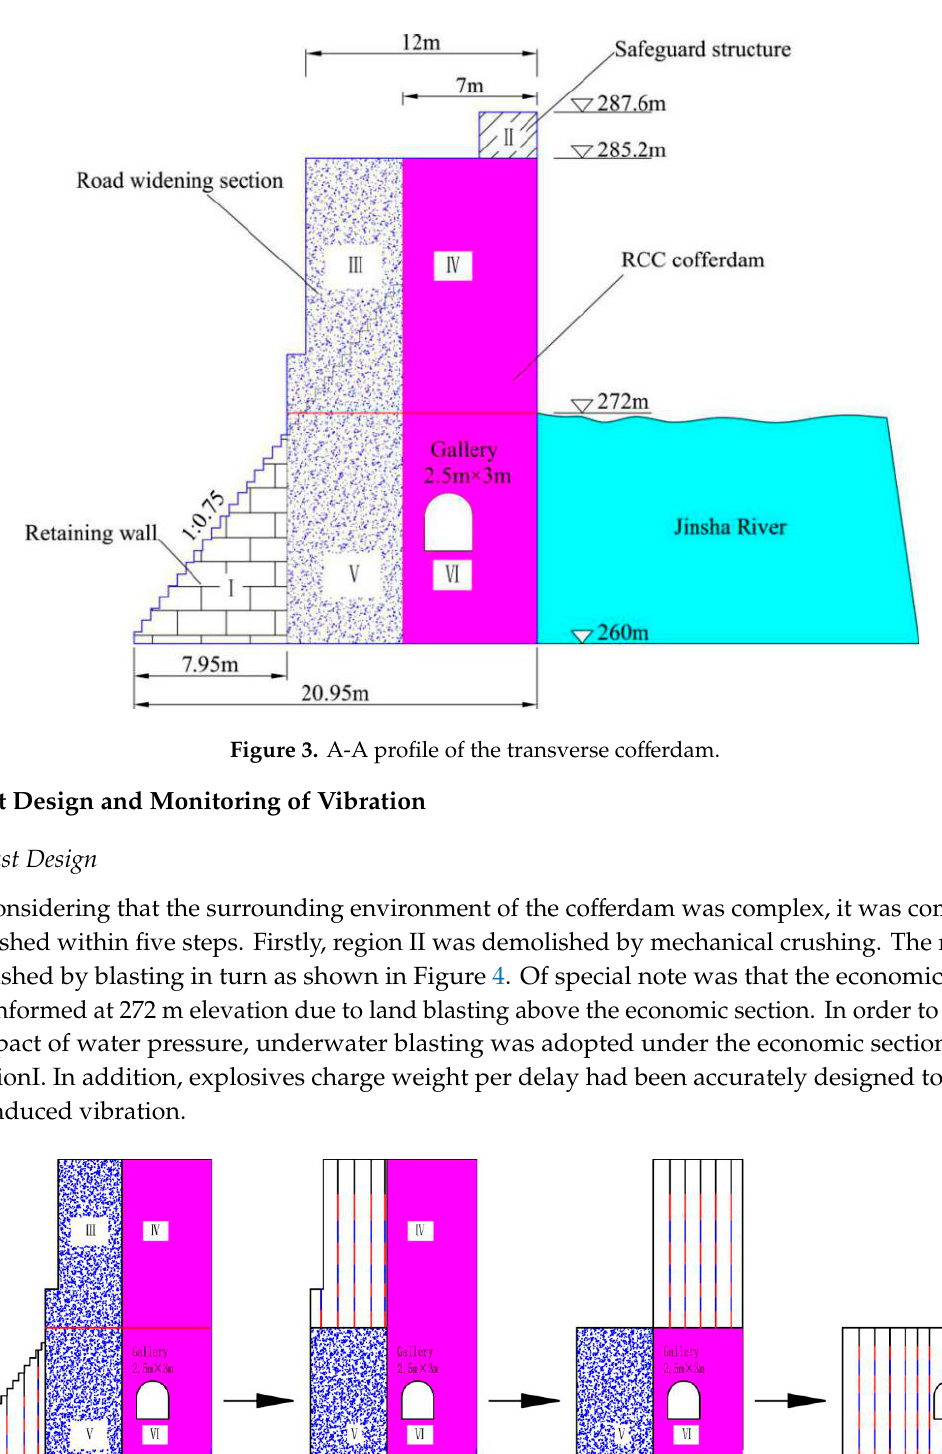
Figure 4. Blasting sequence and blasting hole arrangement.